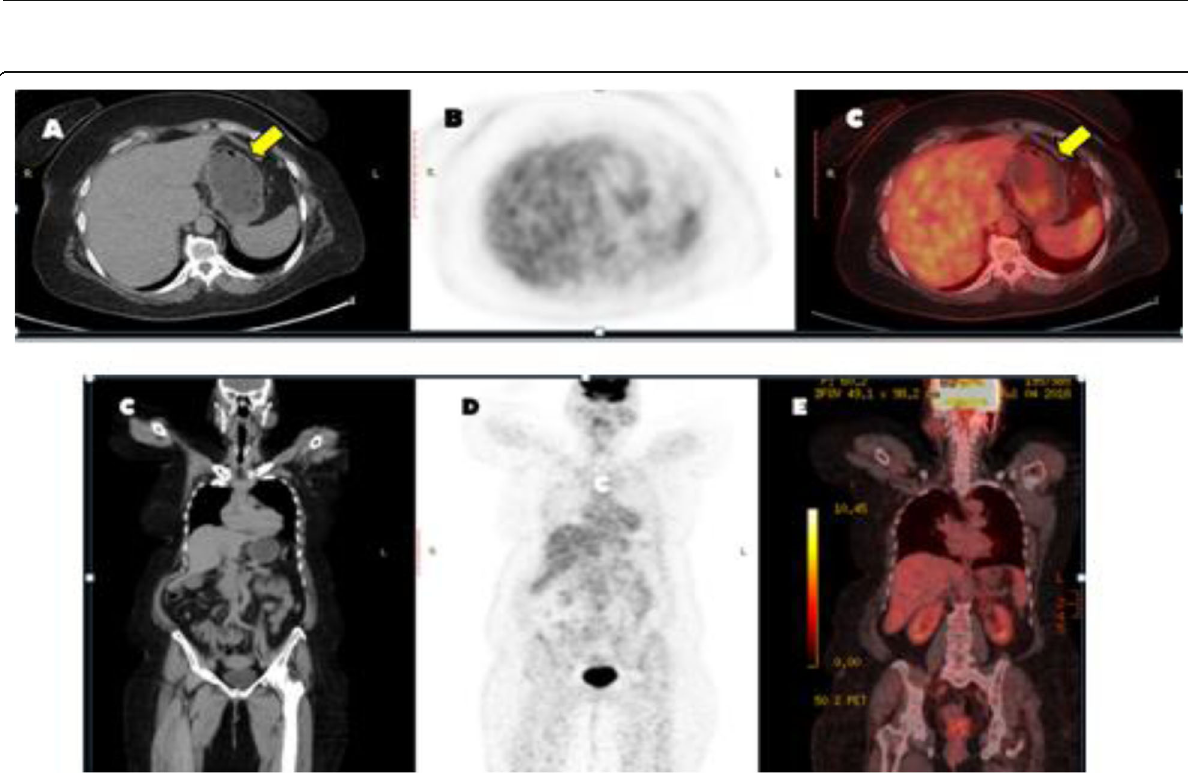
Fig. 5 Axial and coronal post-contrast CT, PET, and fused PET/CT images for a 52-year-female patient with gastric neoplasm; she had received chemotherapy . Images a – c showed no metabolically active residual/recurrent gastric lesions (yellow arrows). Images d – f showed no metabolically active nodal or metastatic